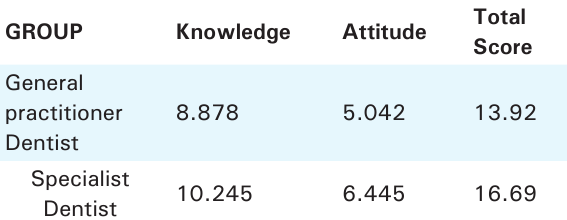
Table 1. The mean score of the knowledge and attitude of the sample.